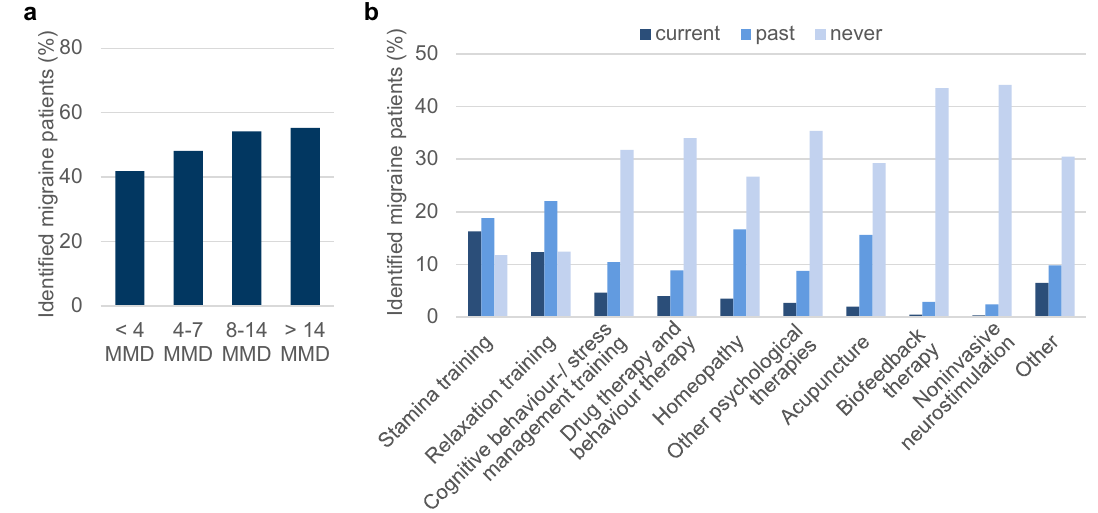
Figure 5. Drug-free prophylactic treatments. ( a ) Graph depicts the percentage of migraine patients that have already tried drug-free prophylactic treatment depending on their MMD. ( b ) Chart shows the percentage of patients that have never tried (light blue), have tried in the past (blue) or are currently using (dark blue) different kinds of drug-free prophylactic treatments. Stamina training includes for example jogging, swimming, or Nordic walking. Behaviour therapy comprises relaxation training, cognitive behaviour therapy, biofeedback therapy or stress management training. “Other” means other non-drug therapy methods for migraine